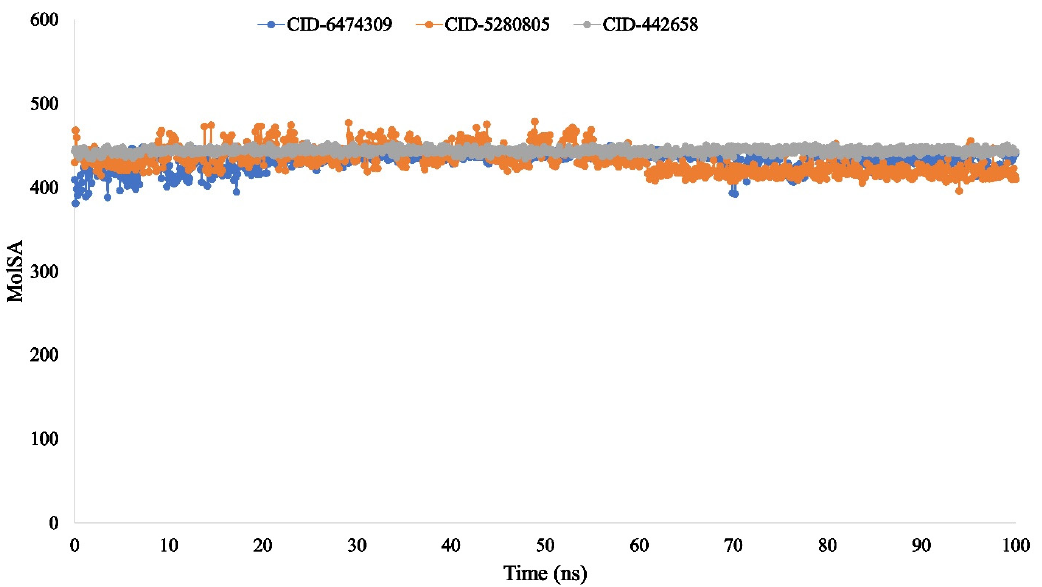
Figure 11. The molecular surface area (MolSA) of the protein–ligand interaction compounds was calculated from the 100 ns simulation interaction diagram. The selected three ligands compound 4,5-di- O -Caffeoylquinic acid (CID-6474309), rutin (CID-5280805), and schaftoside (CID-442658) in association with the selected protein are depicted by green, orange, and grey, respectively.